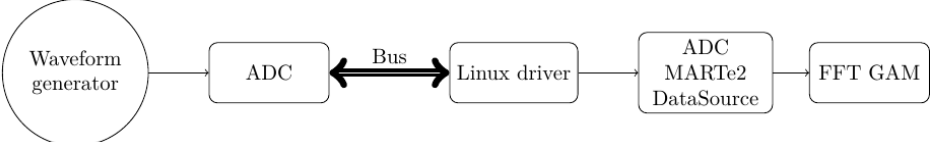
Figure 2. A block diagram of the second test case: the input waveform was acquired by an ADC module that sent data samples over a communication bus (PCIe) to a computer; data were then made available to the ADC data source software component via the Linux driver for the ADC; finally, data were collected by the ADC data source and grouped into blocks of 2048 samples, which were sent to the GAM that was performing the FFT